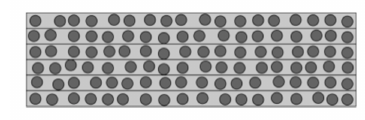
Figure 2. Cross-section of a